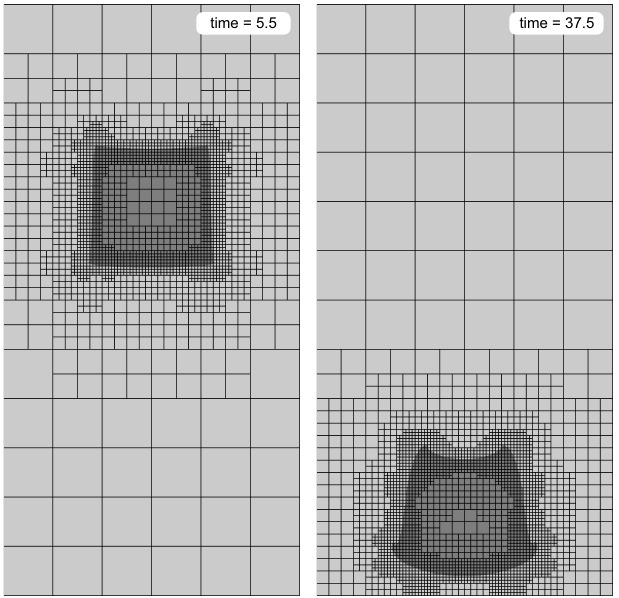
= 10 2 . Material field with η m